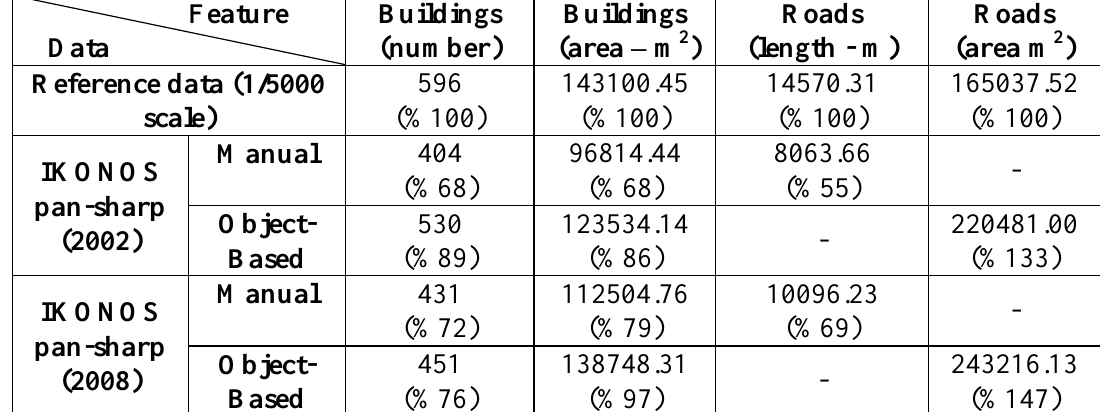
Table 1. Comparable results from the imageries and reference